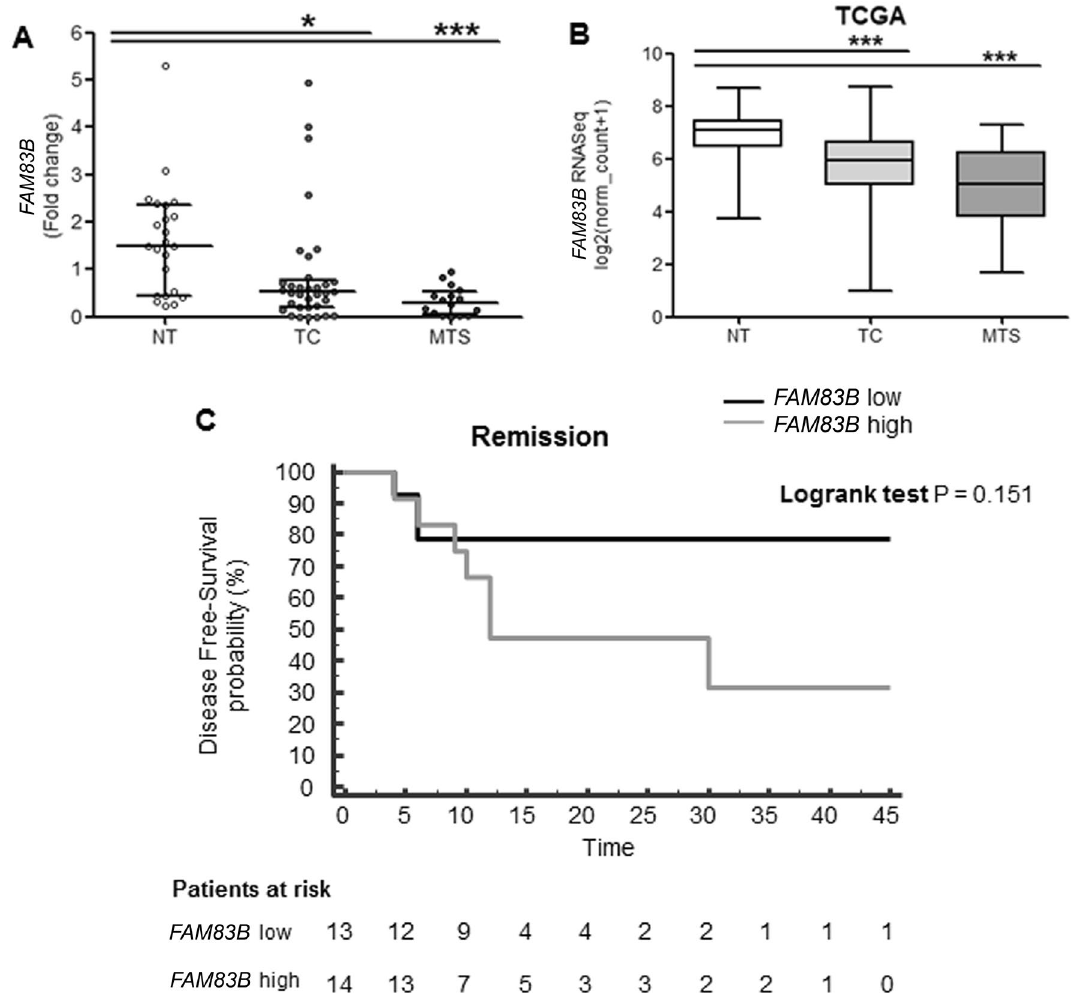
Figure 1. FAM83B mRNA levels in normal and neoplastic thyroid tissues and correlation with disease-free survival (DFS) survival. ( A ) FAM83B levels evaluated in our cohort of 39 patients [Normal Thyroid (NT) n = 24, Thyroid Cancer (TC) n = 34 and Metastasis (MTS) n = 16]. For some patients NT, TC and MTS paired samples were available. Data are shown as dot-plot with median and interquartile range. ( B ) FAM83B levels in TCGA THCA database. Thyroid Cancer (TC) n = 501, Normal Thyroid (NT) n = 58 and Metastasis (MTS) n = 8. Data are shown as box and whiskers (min to max). ( C ) Kaplan–Meier analysis of DFS in patients according to FAM83B expression. Patients were divided in FAM83B -high and FAM83B -low based on FAM83B TC group median value (0.517). Survival curves were generated using the Kaplan–Meier method and the log-rank test was used to evaluate the statistical significance of differences; patients were censored at the time of remission or, in the case of no remission, at the time of the last clinical cell lines. The correlation between FAM83B expression and the clinico-pathological features and prognosis of patients was studied, too. Our results suggest for the first time a role for FAM83B in thyroid cell migration and differentiation, as demonstrated by the reduction of markers of thyroid differentiation and the increase of the mesenchymal marker vimentin, and by the increase in cells migration abilities upon FAM83B silencing. Results FAM83B mRNA levels in normal and neoplastic thyroid tissue: downregulation and thyroid cell dedifferentiation. FAM83B mRNA levels were initially evaluated in 24 normal thyroid (NT), 34 thy- roid cancer (TC) and 16 metastatic (MTS) tissue samples. FAM83B mRNA was significantly downregulated in TC and MTS samples compared to NT (p < 0.05 and p < 0.001, respectively) (Fig. 1A). Similar data were obtained